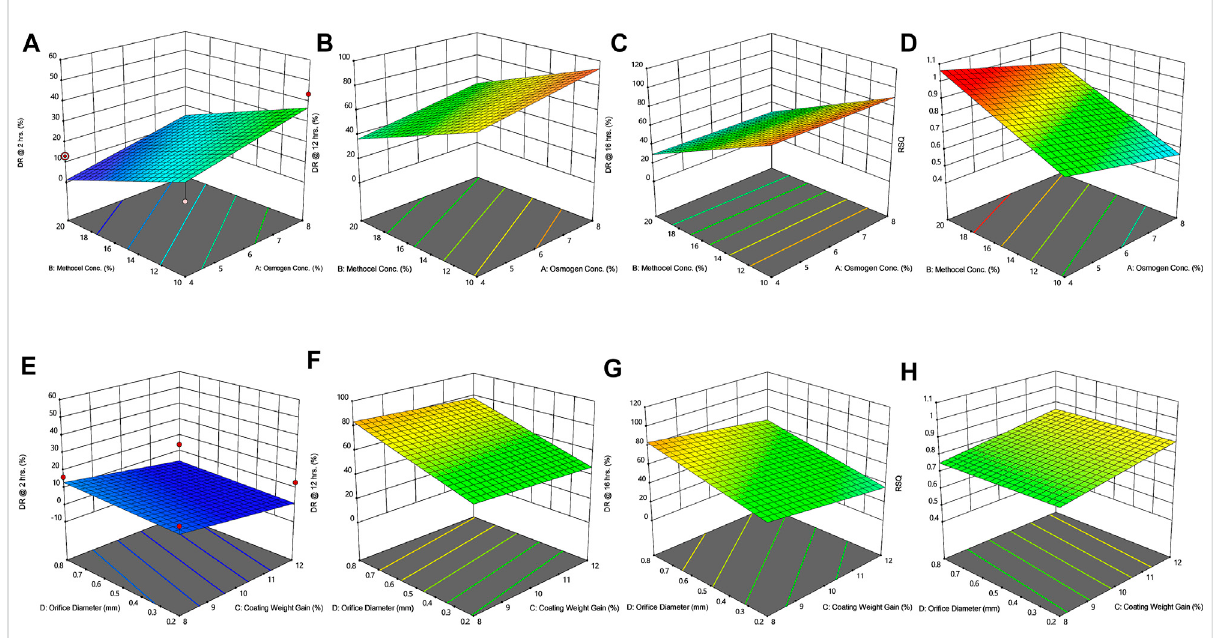
FIGURE 3 Response surface plots (3D) showing the effect of osmogen concentration (X 1 ), Methocel ™ K4M concentration (X 2 ), coating weight gain (X 3 ) and ori fi ce diameter (X 4 ) on the release of F3 formulation (A) at 2 h (B) at 12 h (C) at 16 h (D) on zero-order release coef fi cient ( r 2 ).